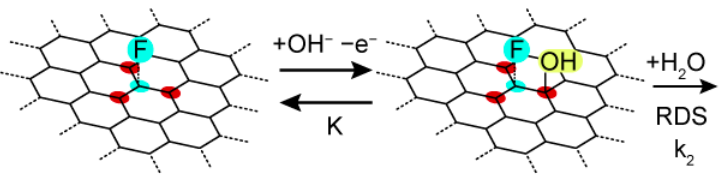
Figure 4. Schematic illustration of the reaction mechanism of F–carbon. Pre-equilibrium of the hydroxide adsorption and one-electron oxidation occurred at positively charged carbon sites (red) with respect to the fluorine-doped carbon sites (blue). The adsorbed hydroxide reacts with H 2 O as the irreversible rate-determining chemical step.